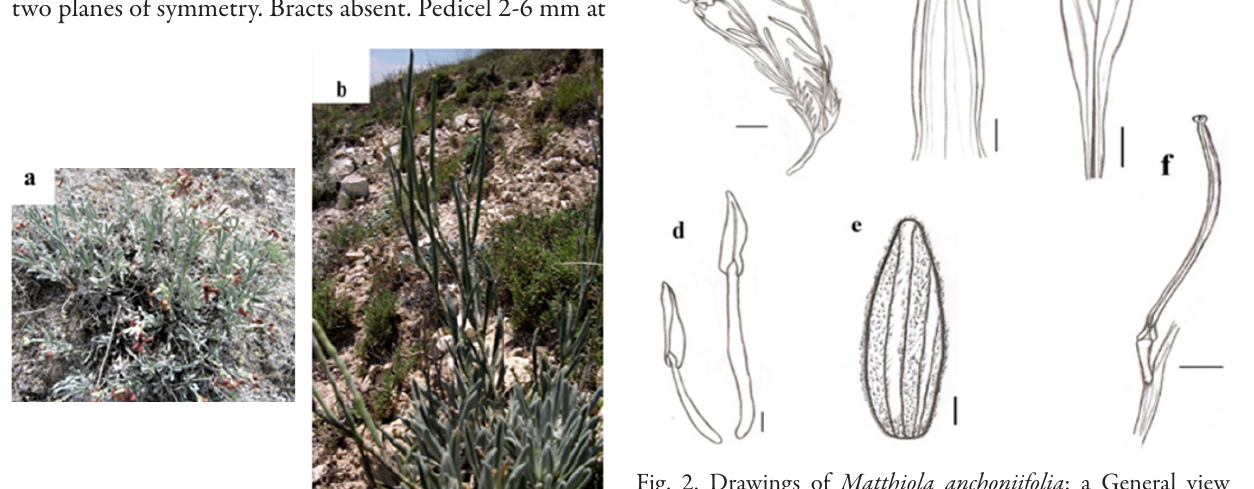
Fig. 2. Drawings of Matthiola anchoniifolia : a General view (Scale bar: 2 cm); b Sepal (Scale bar: 1mm); c Petal (Scale bar: 3 mm); d Stamens (Scale bar: 0.7 mm); e Pistil (Scale bar: 0.4 mm); f Fruit (Scale bar: 1